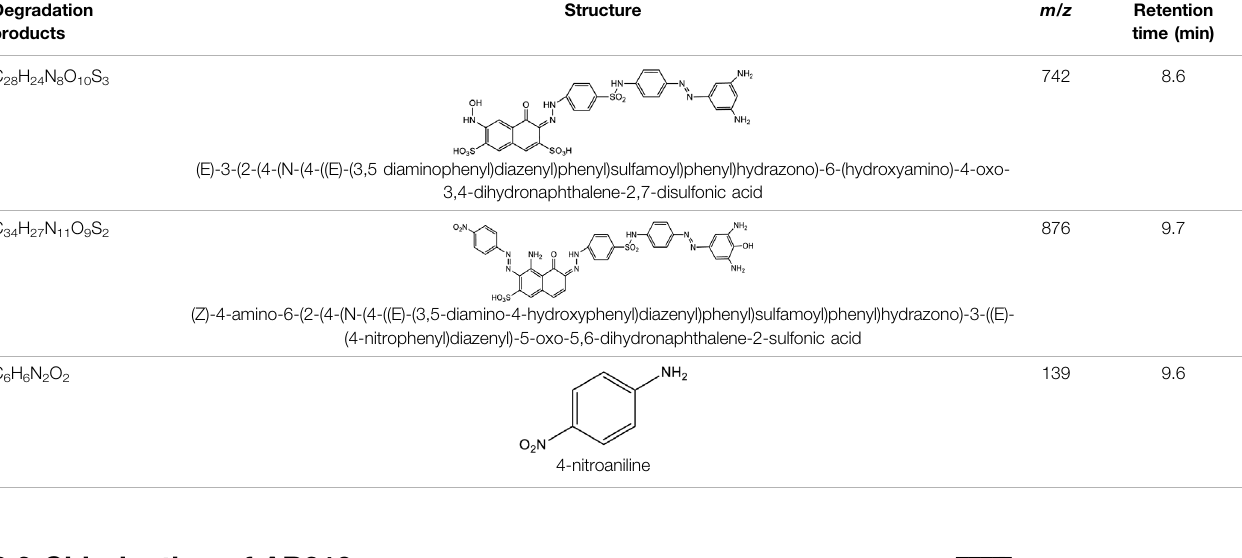
TABLE 1 | Degradation products of AB210 generated after long time estorage, sunlight action for 3 h and chlorination reaction for 300 s. Degradation products